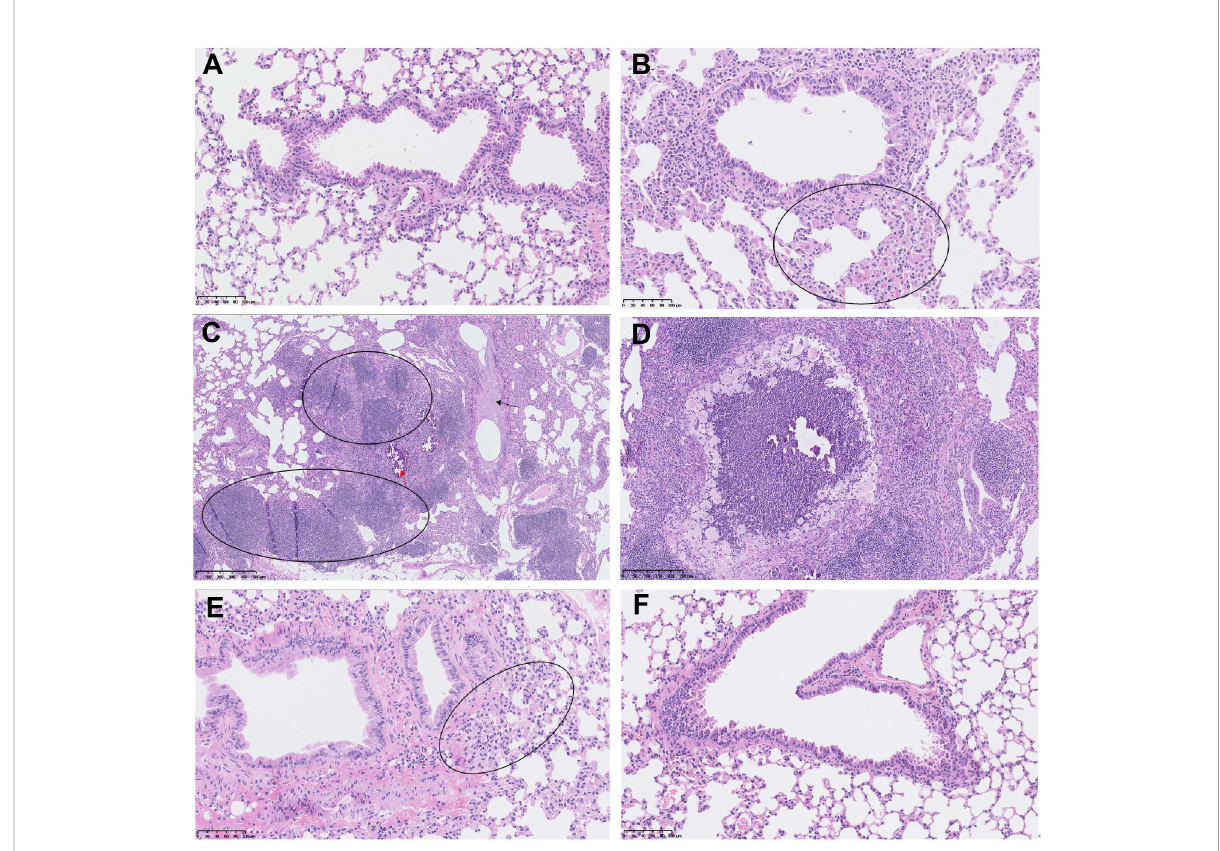
FIGURE 8 The lung lesions in the hACE2 transgenic mice under the infection with Delta variant. (A) The lung tissue of the control mouse without SYS6006 immunization and virus infection (20×); (B-D) The lung tissues of the mice without SYS6006 immunization infected by Delta virus. The marked circles and arrows in the fi gures indicate moderate macrophage aggregation (circle in B, 20×), moderate lymphocyte proliferation (circle in C, 5×), mild thickened alveolar septa (black arrow in C, 5×), slight mineralization (red arrow in C, 5×), and regional necrosis (D, 10×), respectively; (E) The lung tissue of the mouse infected by Delta virus after the immunization with 5 m g of SYS6006 (20×). The circled region indicates slight macrophage aggregation; (F) The lung tissue of the mouse infected by Delta virus after the immunization with 20 m g of SYS6006